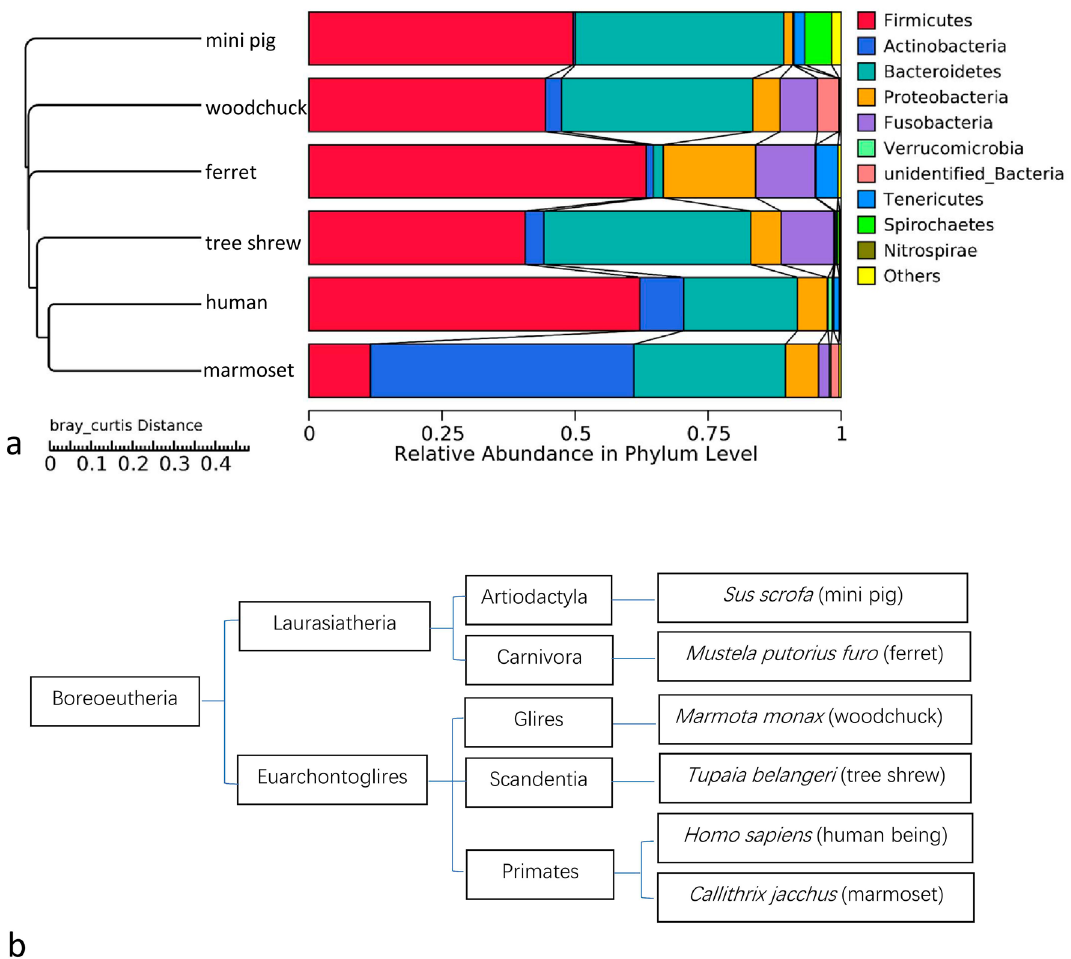
Figure 3. Gut microbiota clustering tree mirrors the taxonomic tree of the hosts. (a) Microbiota profile clustering based on bray_curtis dissimilarities is set to form an OTU hierarchical clustering tree of the overall grouped distribution of microbial species in the gut of each host species. The legend boxes list the 10 most abundant taxa at the phylum level. (b) Taxonomic tree of the six host species in this study is generated based on the taxonomy databases in National Center for Biotechnology Information